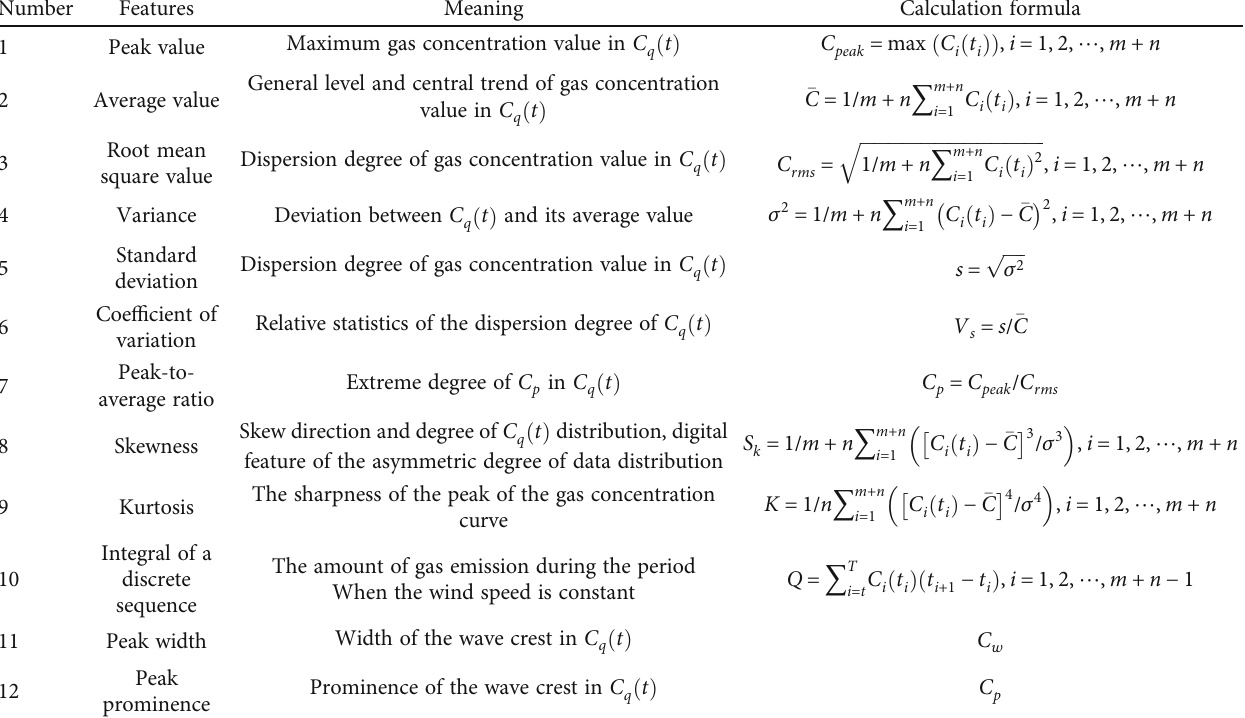
Table 1: Time-domain features of abnormal gas concentration sequence.